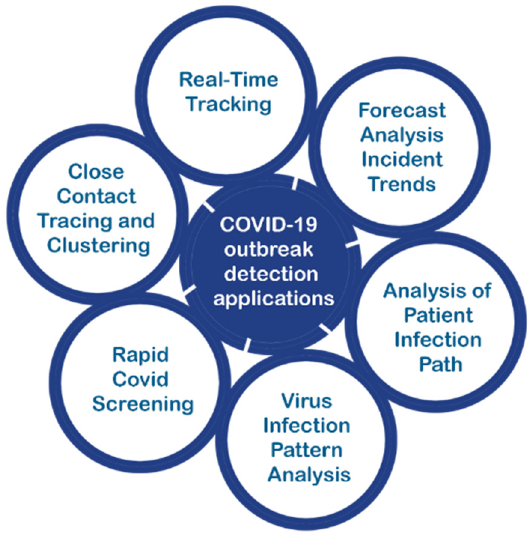
Figure 7. Proposed framework for COVID-19 outbreak